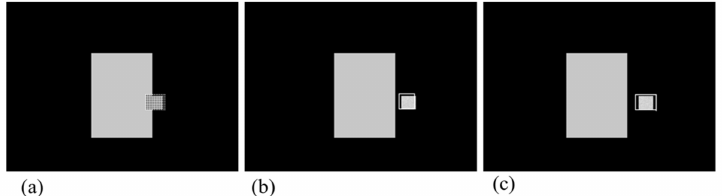
Figure 15. Result of target re-locking. During blind time, the re-locking algorithm is being executed as shown in ( a ). It is shown that the target is re-locked after blind time in ( b ). In ( c ), image tracking is resumed through checking ability of tracking.